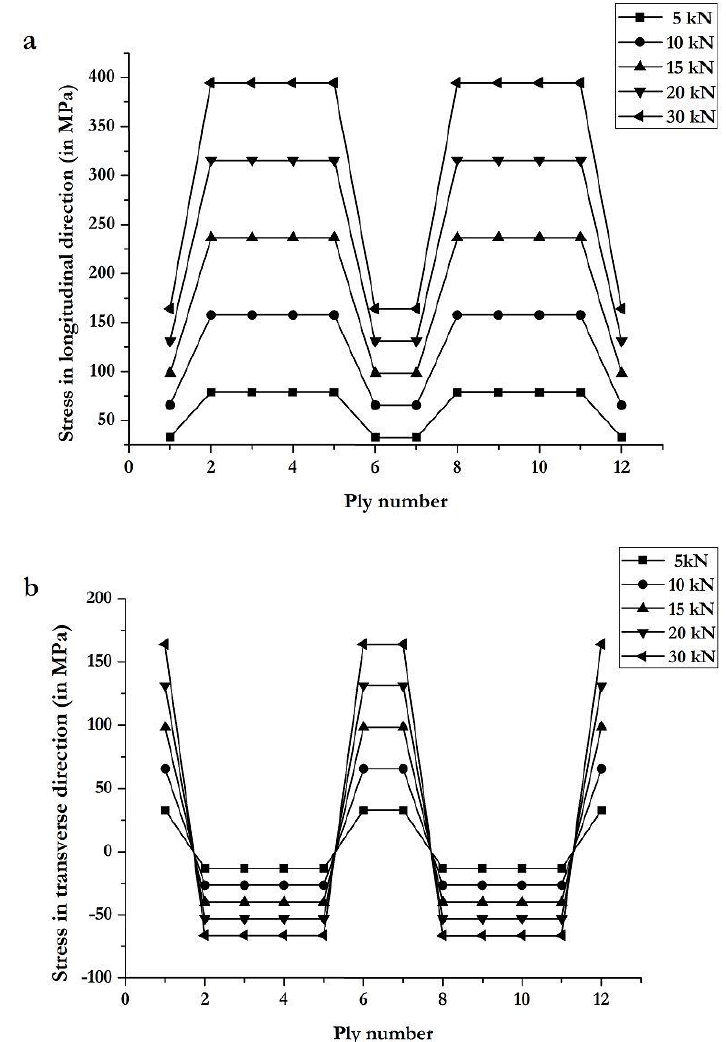
Figure 9. Ply stress distribution computed with Autodesk Helius tool for composite substrate along ( a ) the longitudinal direction and ( b ) the transverse direction.